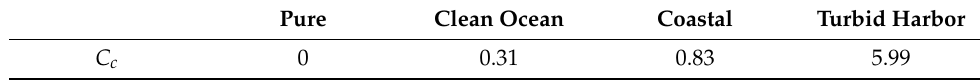
Table 1. Chlorophyll concentration in four types of water (mg/m 3